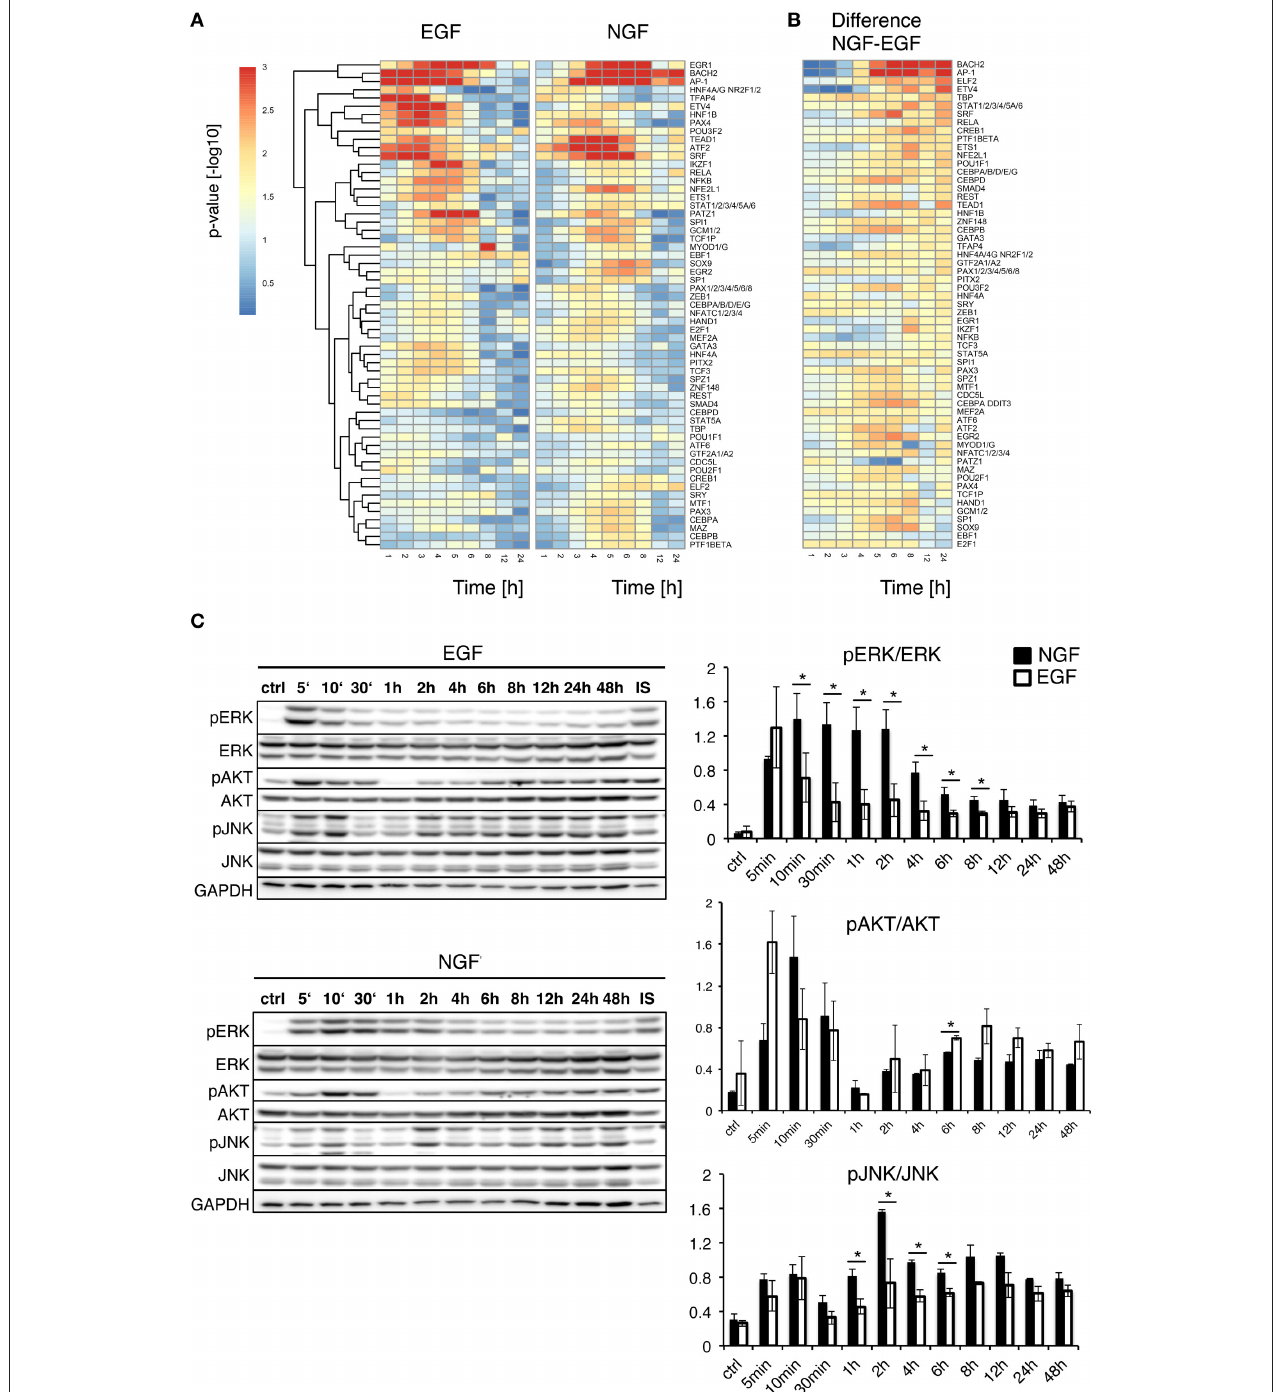
FIGURE 2 | Upstream analysis of gene expression timeseries. (A) Upstream Gene Set Enrichment Analysis for transcription factors. The heatmaps depict the significance of transcription factors putatively controlling the gene response after EGF (left) or NGF stimulation (right). All TFs are significantly regulated (FDR corrected p -value < 0.01 ) after NGF treatment. TFs have been clustered by their Euclidean distance across all conditions using a complete linkage method. (B) Difference in TF p -value significance (NGF-EGF). Rows were ordered from the most positive to the most negative difference at t = 12 and 24h. (C) Time-resolved quantification of pERK, pAKT and pJNK after EGF and NGF treatment. Original western blots from PC12 cells treated with 75 ng/ml EGF and 50 ng/ml NGF over time. GAPDH is shown as loading control, IS: Internal Standard. Statistical analysis of the pERK/ERK, pAKT/AKT and pJNK/JNK levels are shown on the right panel. An increased and significant higher pERK/ERK level is shown in NGF stimulated (shown as black bars) cells compared to EGF (shown as white bars). A similar trend is visible for pJNK/JNK. A * denotes a p -value < 0.05 , data points obtained in duplicates and triplicates.